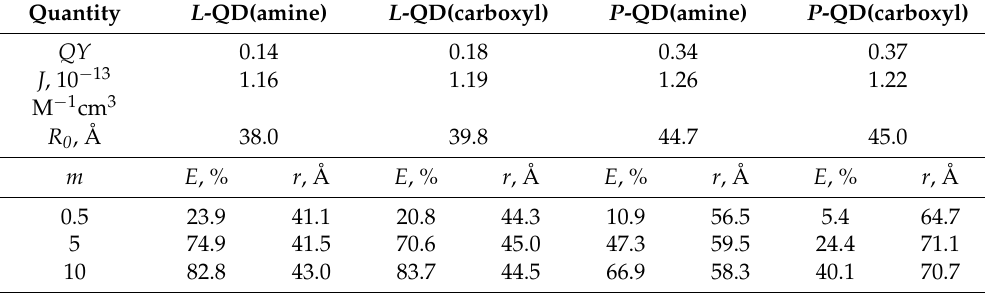
Table 1. FRET parameters for different types of QD:Ce 6 complexes at various Ce 6 amounts ( m ).